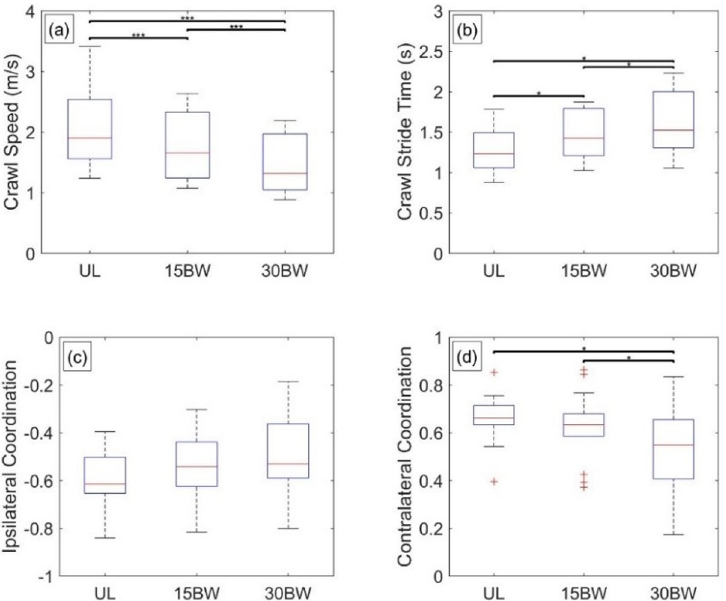
Fig 17. High crawl statistical results. Boxplots depicting the results from the Tukey post hoc analysis for a) crawl speed, b) crawl stride time, c) ipsilateral coordination, and d) contralateral coordination. The bars denote significant differences between loading conditions at a significance level α = 0.05 � , 0.01 �� , 0.001 ��� .